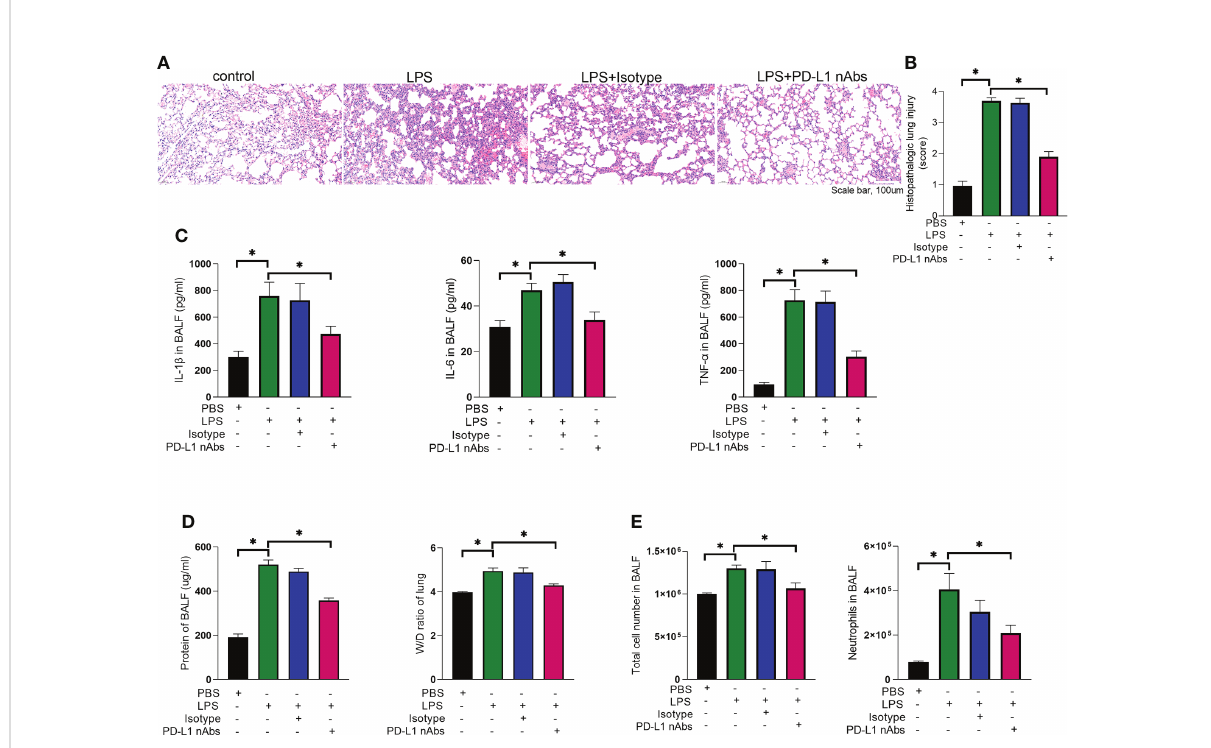
FIGURE 7 Anti-PD-L1 antibody has an ameliorating effect on the pathogenesis of ARDS. (A – E) C57BL/6 mice injected intratracheally with LPS (10mg/kg) were treated with anti-PD-L1 antibody (50ug/mouse) or Isotype antibody for 24h. (A) Representative histological section of the lungs was stained by HE staining, magni fi cation (bar=100um). (B) The lung injury scores were determined. (C) IL-1 b , IL-6, TNF- a in BALF. (D) BCA assay was used to determine the total protein concentration in BALF and lung tissues were weighed to calculate the W/D ratio. (E) The total cells and neutrophils detected by fl ow cytometry in BALF. The values presented are mean ± SEM (n=6; *P<0.05, one-way analysis of